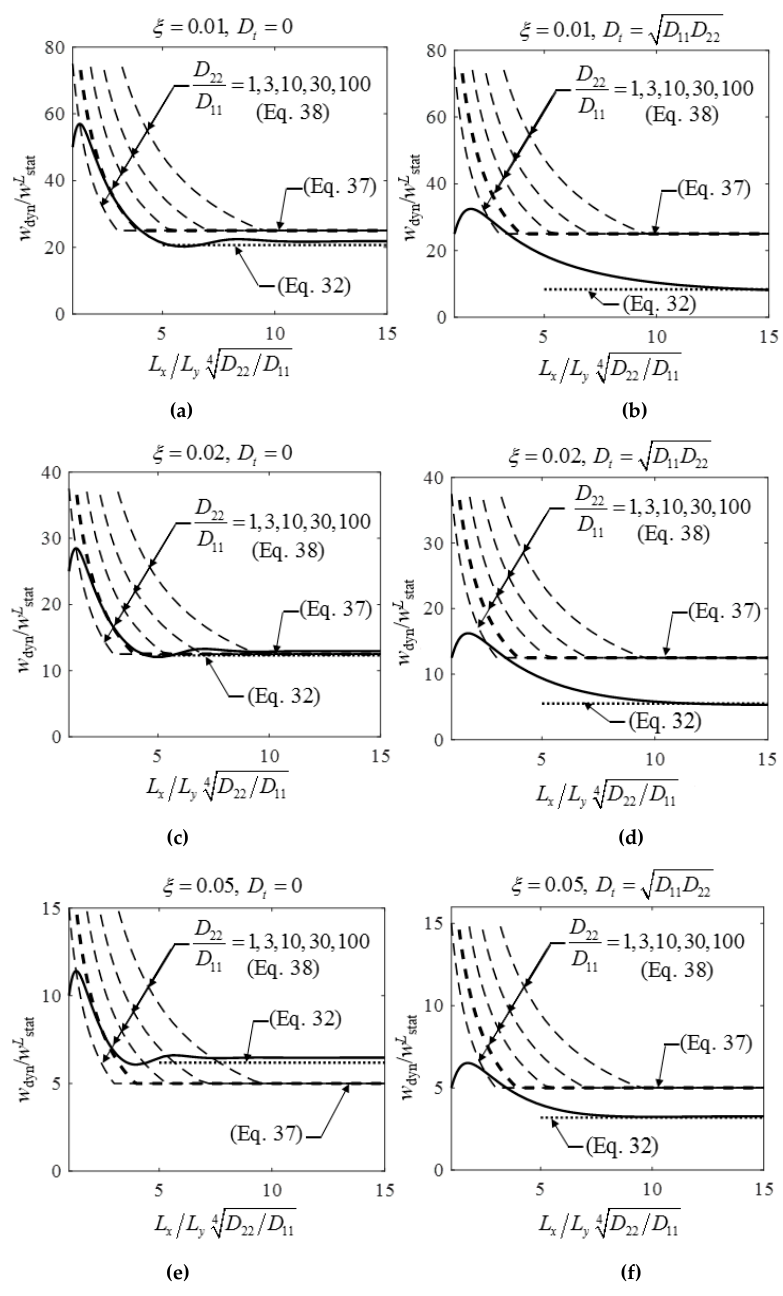
Figure 16. Dynamic displacements of a plate subjected to a concentrated load at resonance. The displacements are normalized by the static response of an L y wide plate strip w L the left the plate has no torsional stiffness while on the right correspond to ξ = 1%, 2%, and 5% damping ratios. The accurate solution is given by black continuous lines, Equations (37) and (38) by dashed lines, and Equation (32) by dotted lines.